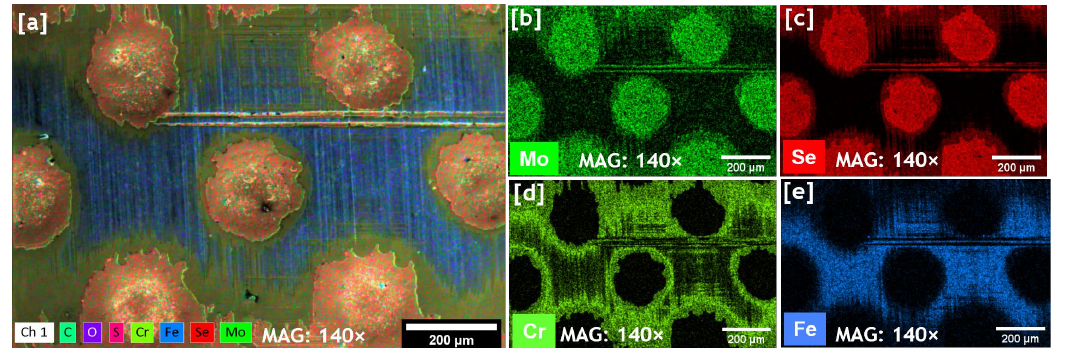
Figure 11. SEM image of ECP_ S C MoSeC specimen showing: ( A ) Image of textured surface; ( B ) Mag- nified image of dimple; ( C ) EDS data.